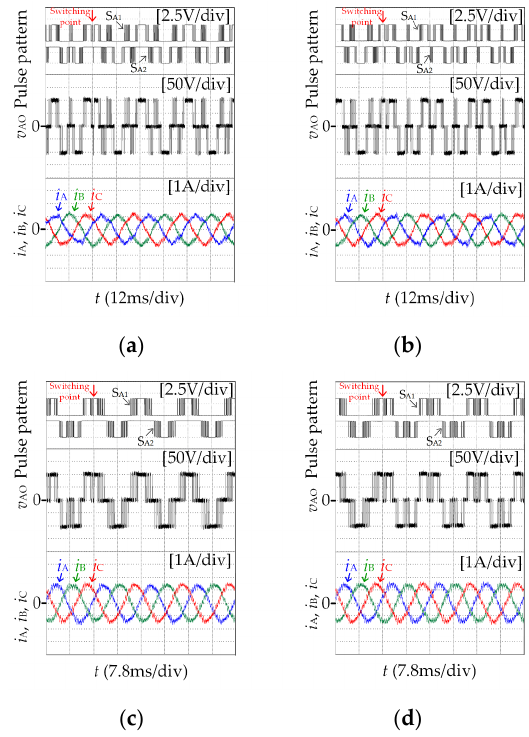
Figure 11. Experimental results of different clamping method switching of SSVM. ( a ) SVM_15(IV) → SSVM_15(I). ( b ) SSVM_15(I) → SSVM_15(IV). ( c ) SVM_11(IV) → SSVM_11(I). ( d ) SSVM_11(I) →